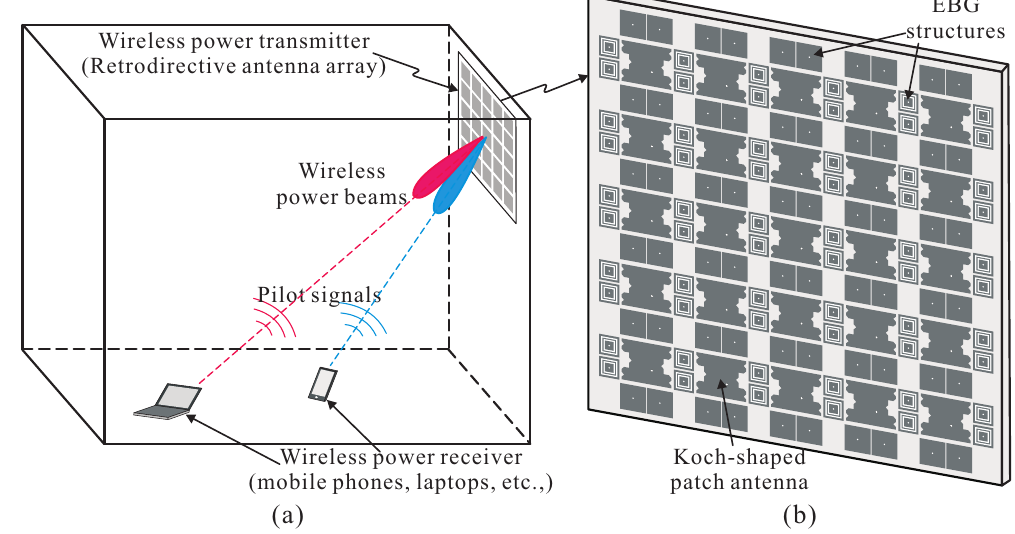
Figure 1. ( a ) Depiction of the wireless power transmission scheme in a typical indoor environment; ( b ) Configuration of the proposed CP RDA. CP RDA: Circularly polarized retrodirective